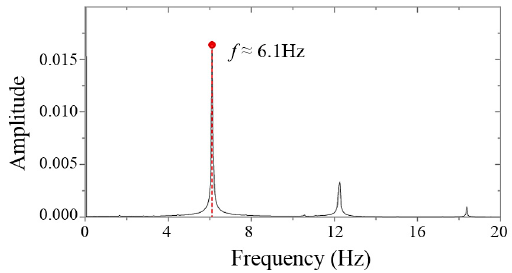
Figure 9. Fast Fourier Transform (FFT) analysis of C PR (vaned diffuser) .